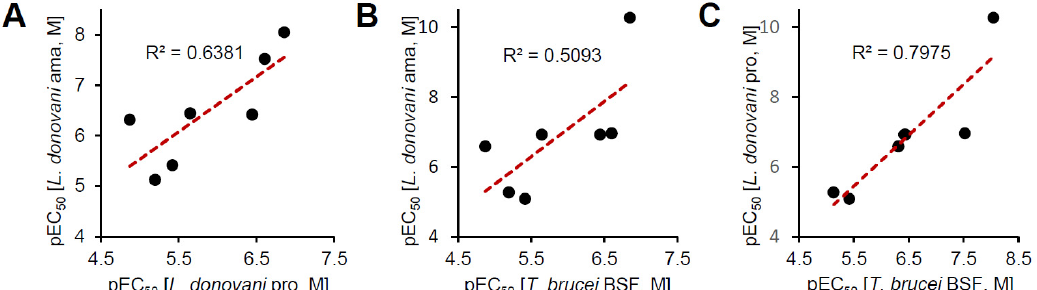
Figure 5. Correlation of pEC 50 values for seven mTOR / PI3K inhibitors against L. donovani and T. brucei. ( A ) Correlation of pEC 50 values against intracellular L. donovani and promastigotes. ( B ) Correlation of pEC 50 values against intracellular L. donovani and T. brucei BSF. ( C ) Correlation of pEC 50 values against L. donovani promastigotes and T. brucei BSF.